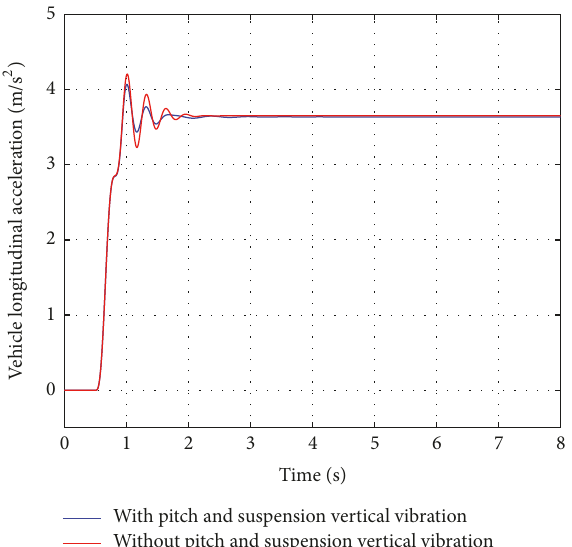
Figure 17: Longitudinal acceleration with/without pitch and sus- pension vertical vibration on low friction coefficient road.